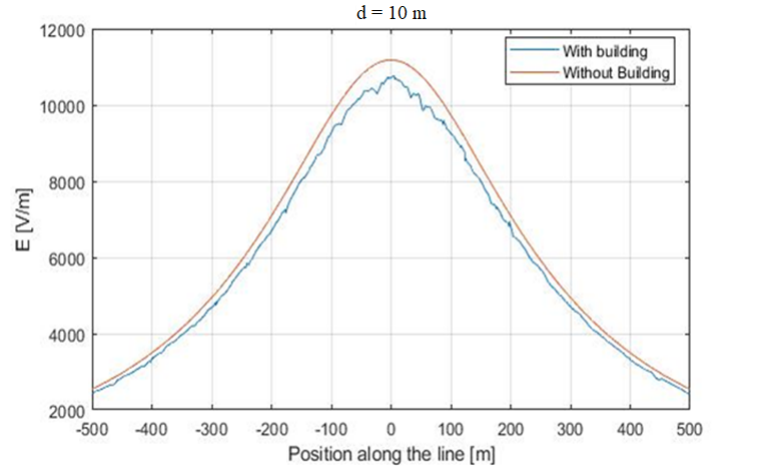
Figure 7. Comparison between the electric field measured along the whole line. (B) H = 5 m, and d varies from 5 to 200